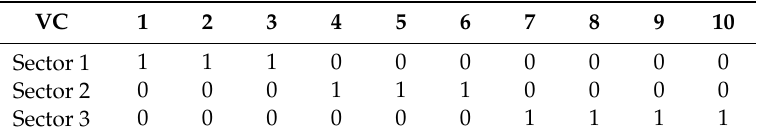
Table 2. First type of representation of solution z .